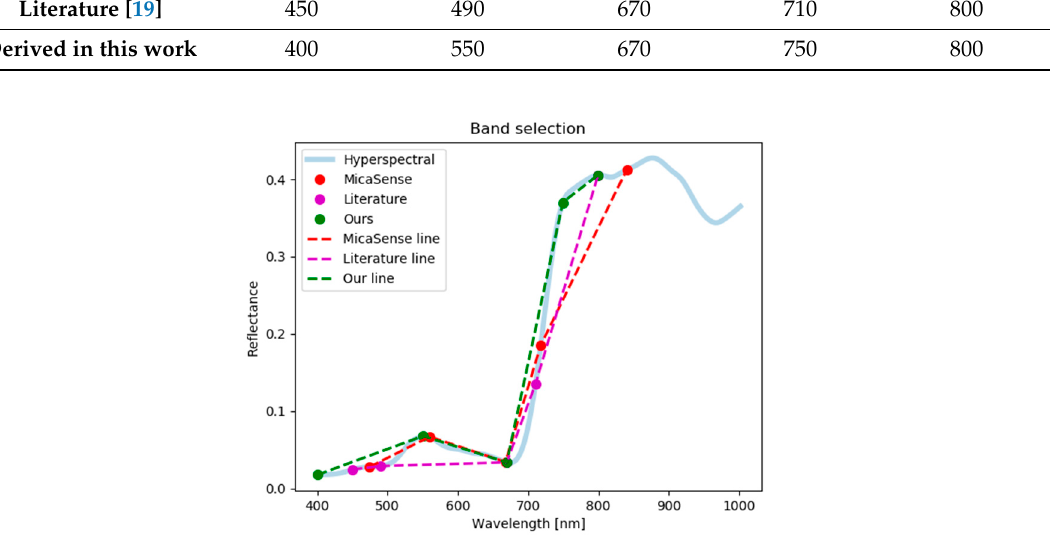
Figure 9. Illustration of different sampling strategies: MicaSense (red), informative wavelengths available in literature [19] (magenta), and newly derived informative wavelengths (green).